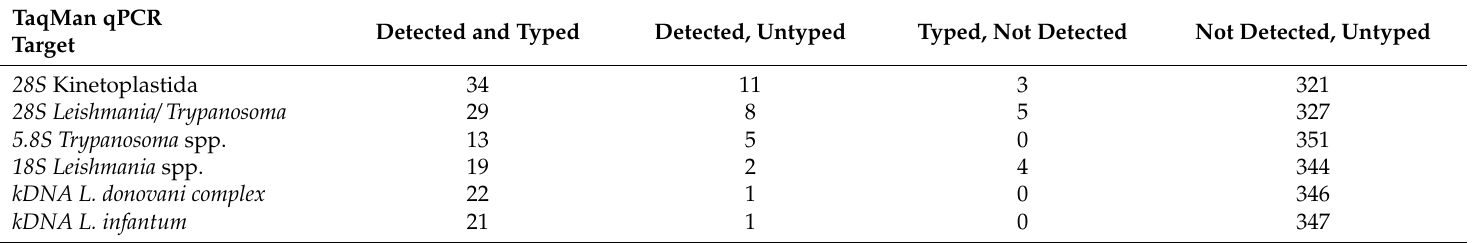
Table 5. Performances of the TaqMan qPCR assays according to the sequencing